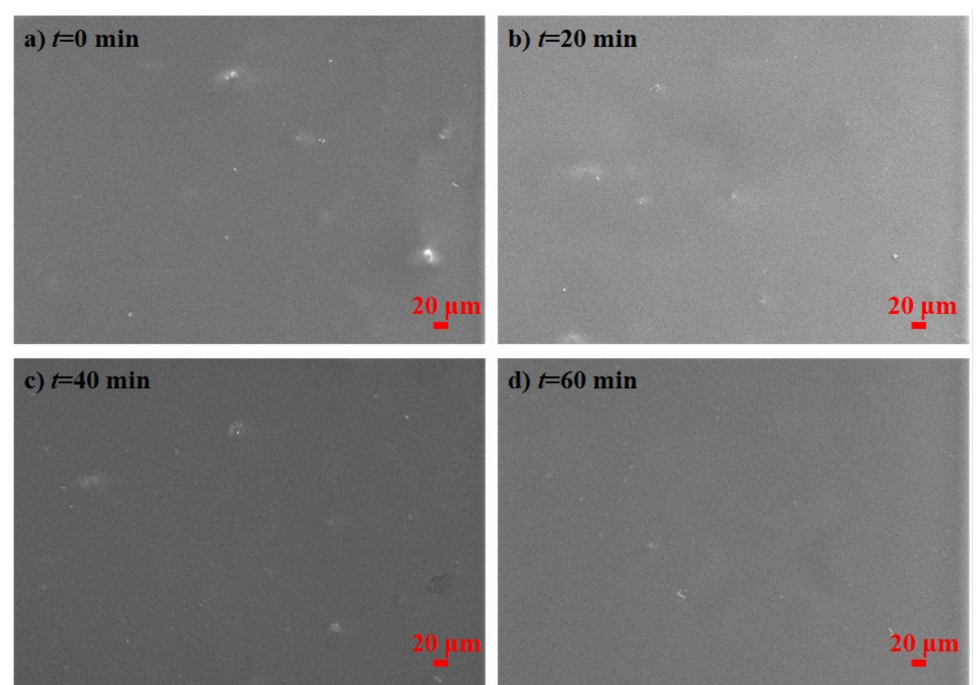
Figure 1. SEM images of the emulsified nanoparticles in crude oil at the 10,000 ppm nanoparticle and 2000 ppm Span 80 at ( a ) t = 0 min, ( b ) t = 20 min, ( c ) t = 40 min and ( d ) t = 60